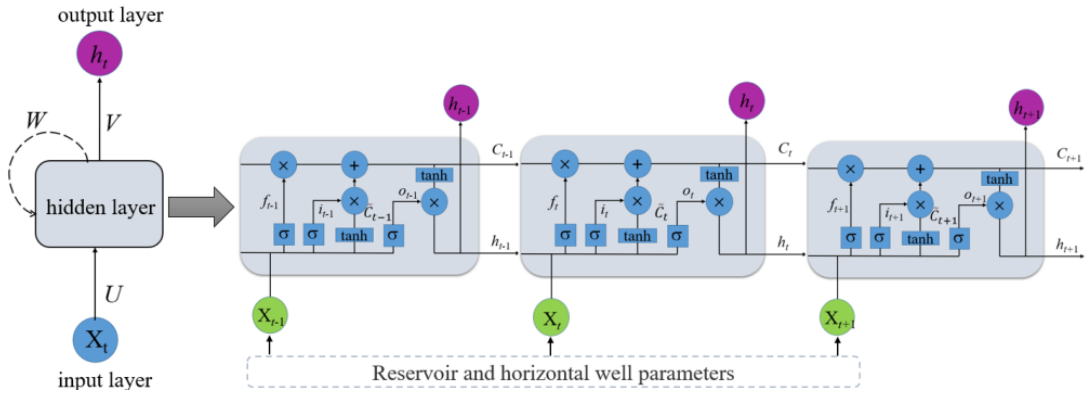
Figure 5. Structure of LSTM neural network.